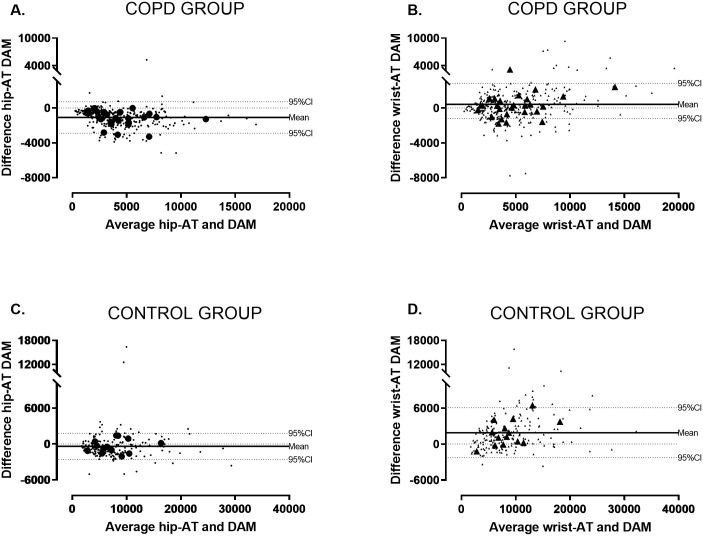
Bland-Altman plots with mean and 95%CI for hip-AT and wrist-AT compared to DAM.(A, B) patients with COPD; (C,D) healthy controls; Large symbols represent the average individual step count per subject in the study (N = 28 for COPD and N = 14 for healthy controls). Small dots represent the daily physical activity expressed as steps per day. Mean and 95%CI are calculated based on average step count data. Hip-AT = Fitbit Zip; wrist-AT = Fitbit Alta; DAM = Dynaport Movemonitor.